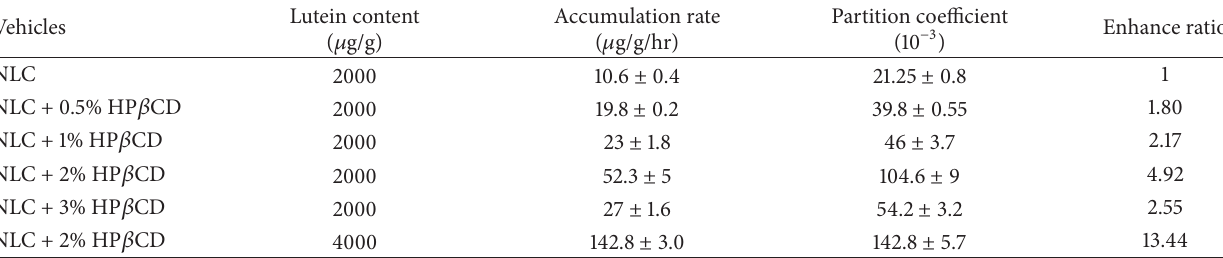
Table 2: Summary of corneal lutein delivery using CD combined with NLCs.